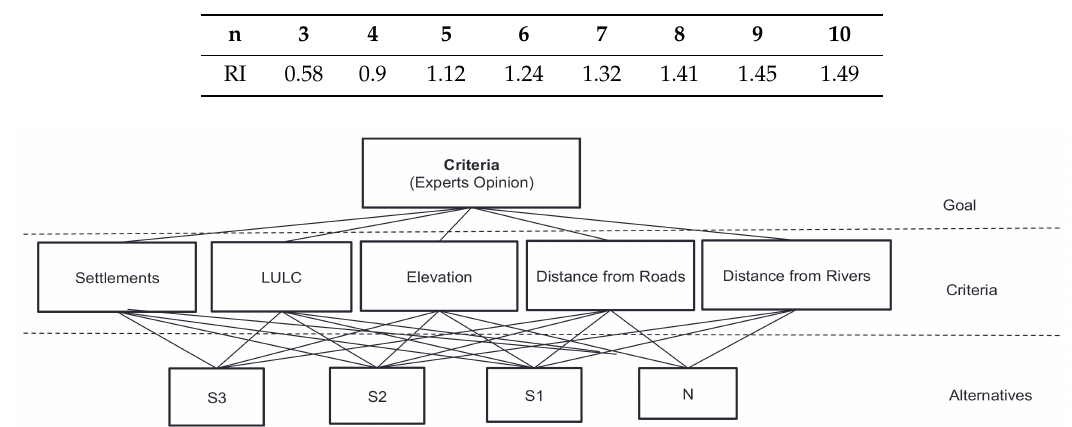
Table 6. Random indices in the AHP.